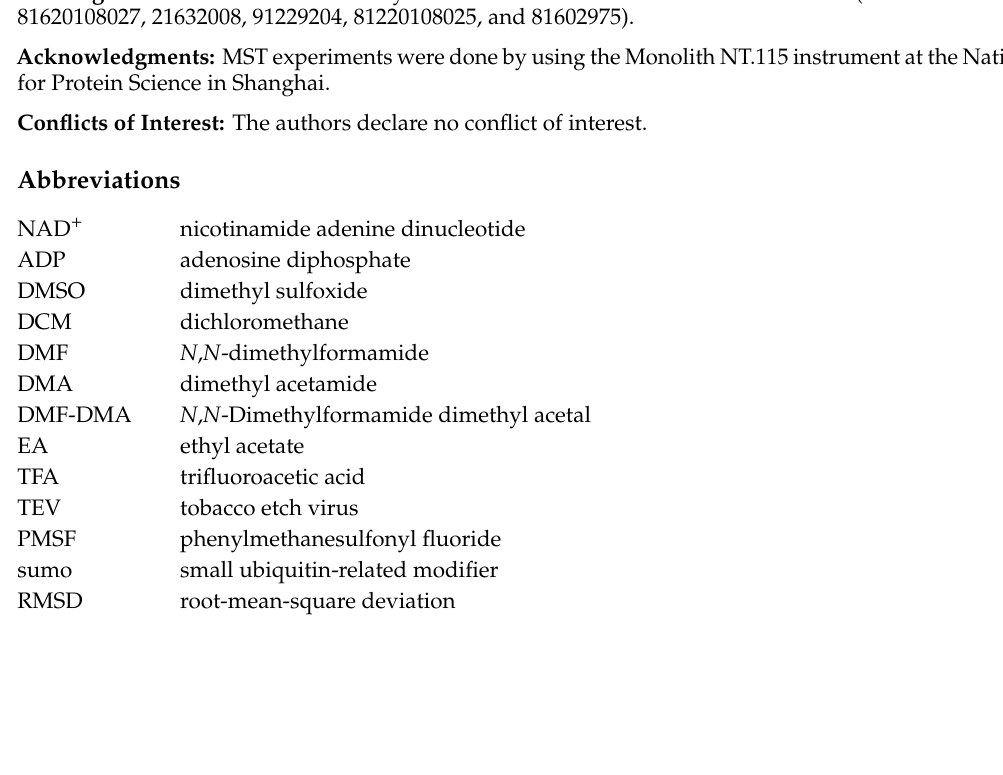
Supplementary Materials: The following are available online. Table S1: HPLC analyses of all the target compounds, Figure S1: 2D schematic representation of the interactions of the compounds with SIRT3, Figure S2: MTT assays to evaluate the toxicity of compounds 4 and 15 , Figure S3: The stability of the